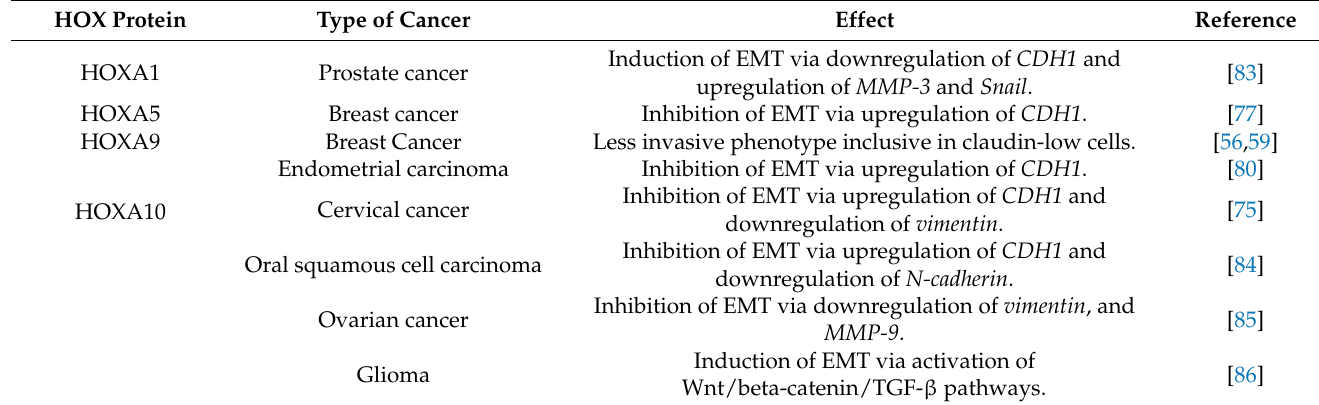
Table 1. Proposed role of the HOX proteins in the EMT and MET in distinct cancer types. HOX